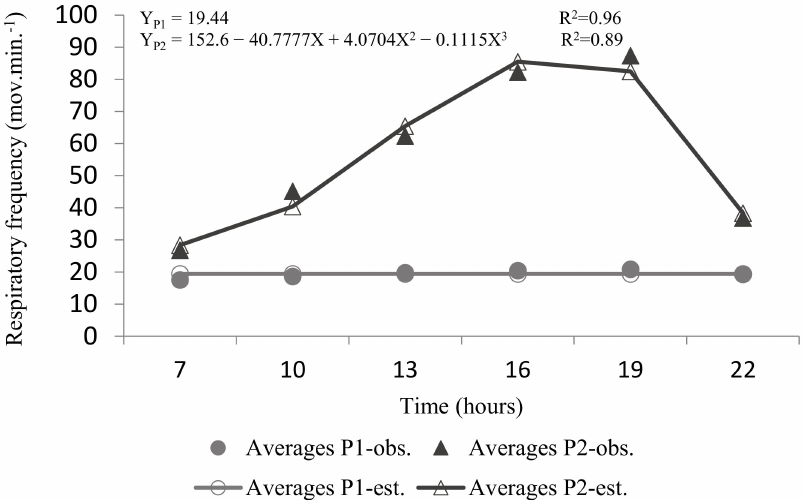
Figure 6. Regression equations between the variable of respiratory frequency (RF) over the hours in P1 and P2 (observed values vs. predicted values)